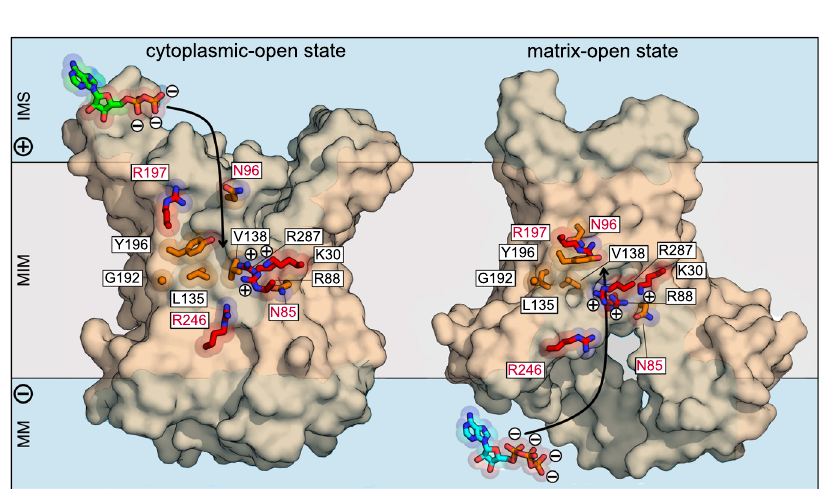
Fig. 6 Two asparagine/arginine pairs guide substrates ADP and ATP to and away from the central binding site as part of the transport cycle. Lateral views from the membrane of the cytoplasmic-open state (left) (ScAac2, PDB code 4c9h chain A) and matrix-open state (PDB code 6gci chain A) (right) of the mitochondrial ADP/ATP carrier. The interacting residues of ScAac2 are conserved in TtAac and to facilitate comparison we used the TtAac labelling (Supplementary Fig. 3). The water-accessible surfaces, determined by HOLE 59 , are shown in transparent blue. Residues of the water- fi lled cavity that have critical and important roles in substrate binding are represented in red and orange, respectively, while the substrates ADP and ATP are shown in green and cyan, respectively. The water-accessible surfaces are shown in